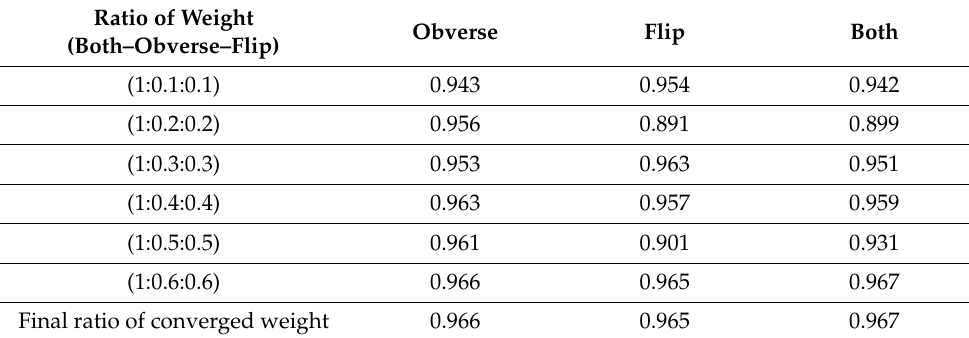
Table 8. Ratio of weight obtained at all three sides of the input X-ray